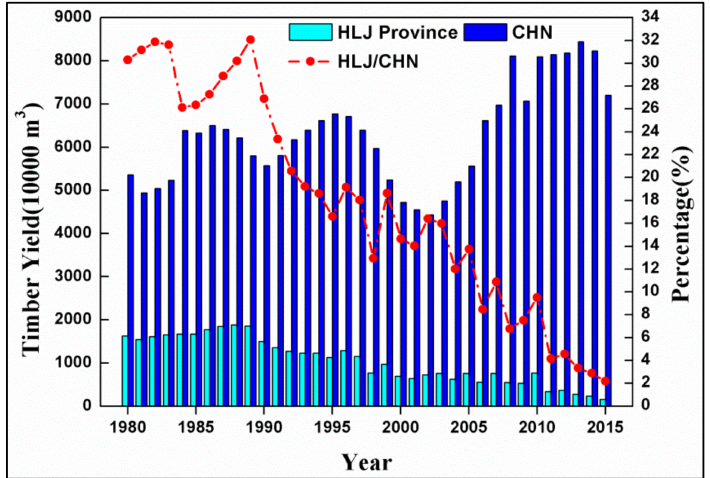
Figure 14. Variation in timber yield in Heilongjiang Province since 1980.